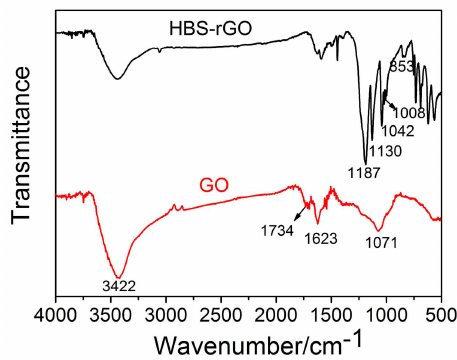
Figure 5. The Fourier transform infrared spectra (FTIR) spectra of GO and